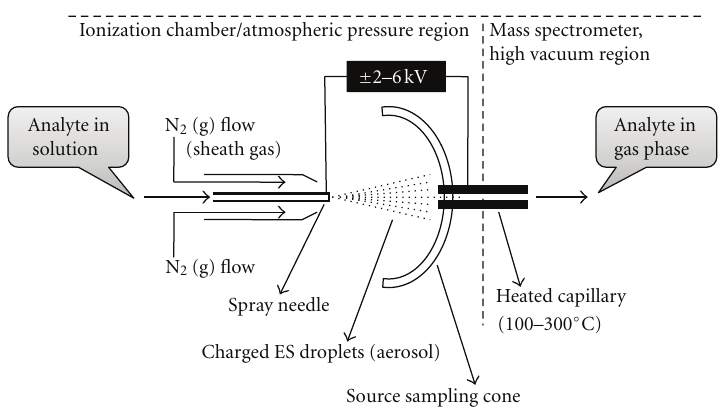
Figure 3: A schematic representation of the ESI-ion